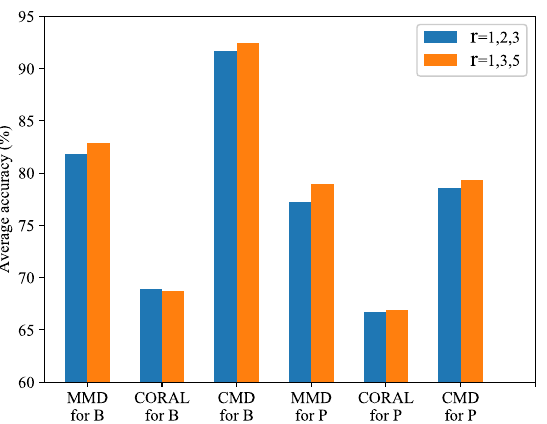
Figure 9. Average accuracy of FFCNN with different dilate rate on all tasks. B tasks are the tasks evaluated on CWRU dataset, and P tasks are the tasks evaluated on Paderborn dataset.